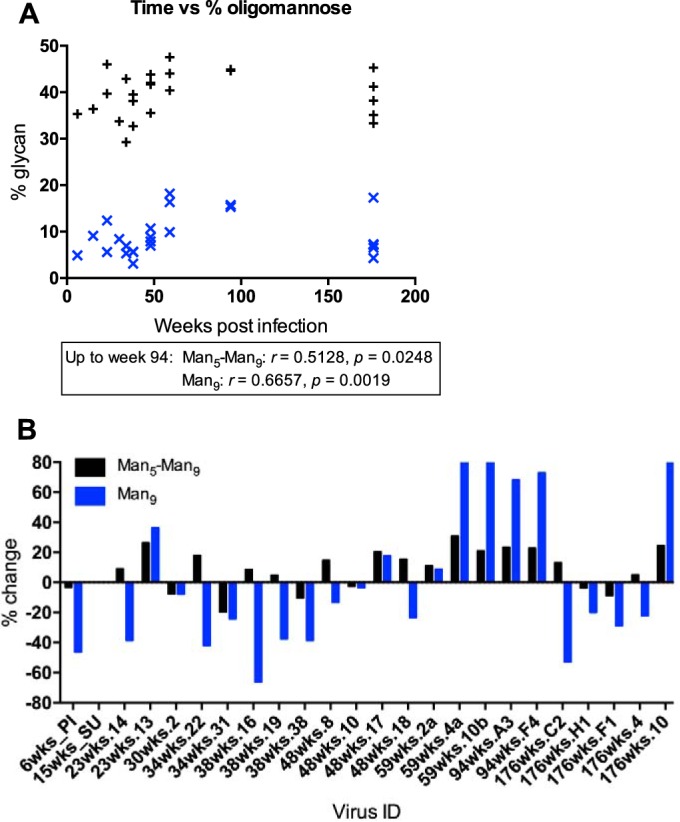
(A) Correlation between number of weeks postinfection and abundances of Man5–9GlcNAc2 and Man9GlcNAc2. (B) Percent change in Man5–9GlcNAc2 and Man9GlcNAc2 compared to the SU virus for each CAP256 gp120 clone studied {percent change = [(percent CAP − percent SU)/percent SU] × 100}. The correlations were assessed by Pearson analyses; P values and r values are indicated.